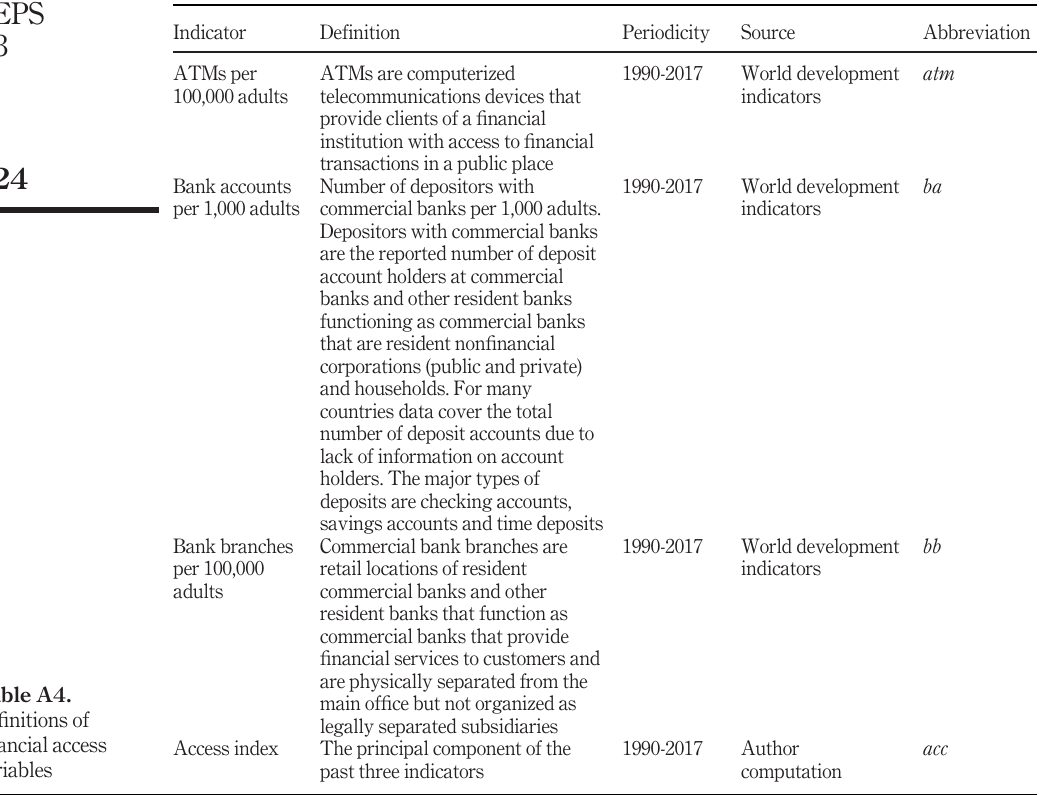
Table A4. De fi nitions of fi nancial access